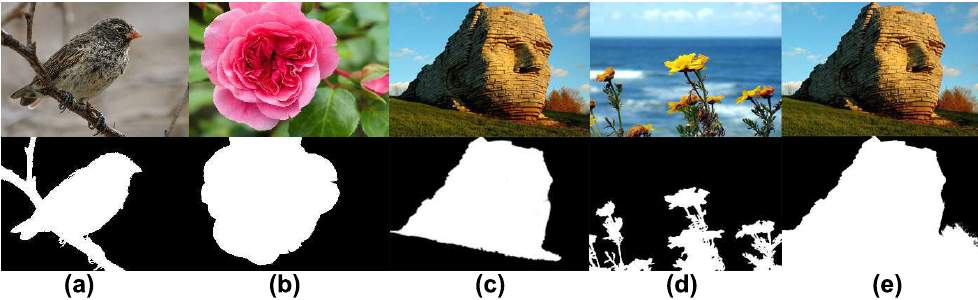
Figure 4. Examples of different definitions of ROIs. The first row contains color images and the second row contains the corresponding ROI maps ( a ) ROIs defined according to sharpness. ( b ) ROIs defined according to color saliency. ( c ) ROIs defined as object regions ( d , e ) Our ROI definition based on both sharpness AND color